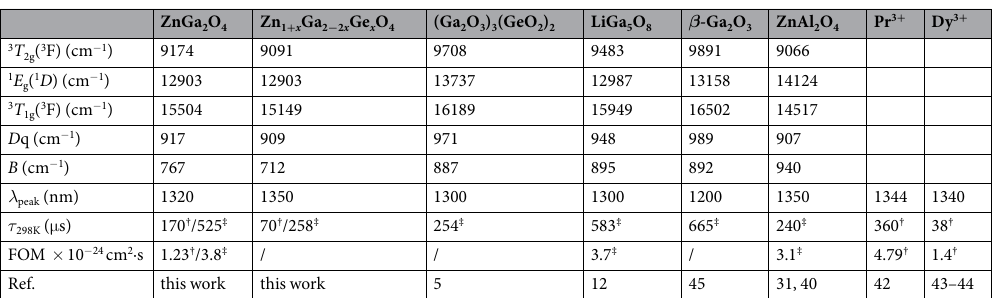
Table 1. Comparison of luminescent properties and crystal field parameters of GCs containing different nanospinels. Rare earth (Pr 3 + or Dy 3 + ) doped glasses emitting at similar O -band wavelengths are also listed for comparison. † 1/ e lifetime and ‡ average